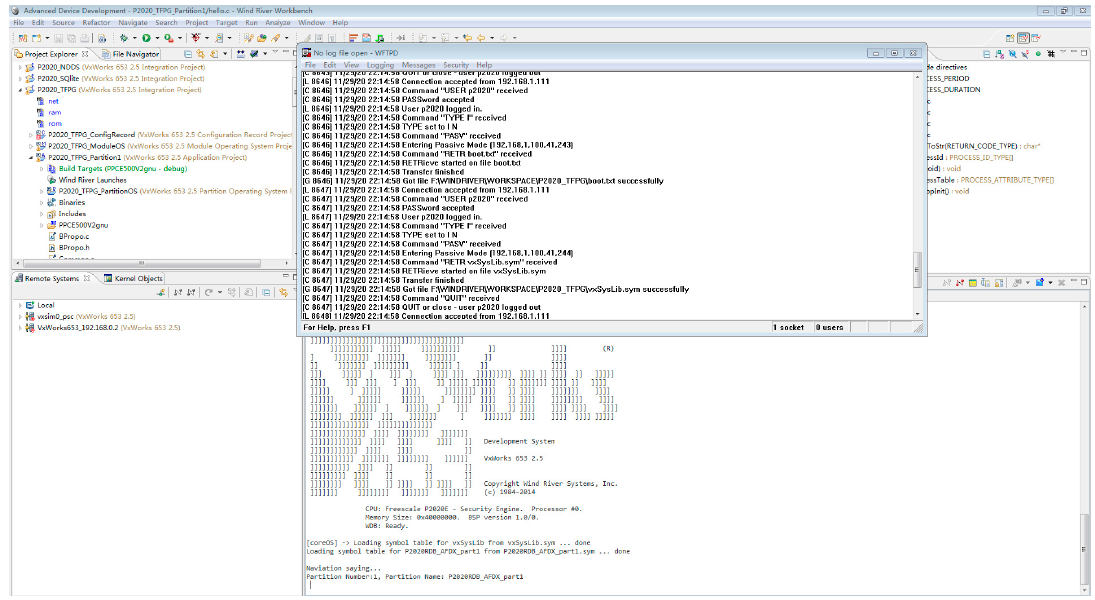
Figure 11. The interface of VxWorks 653 and the basic configuration.